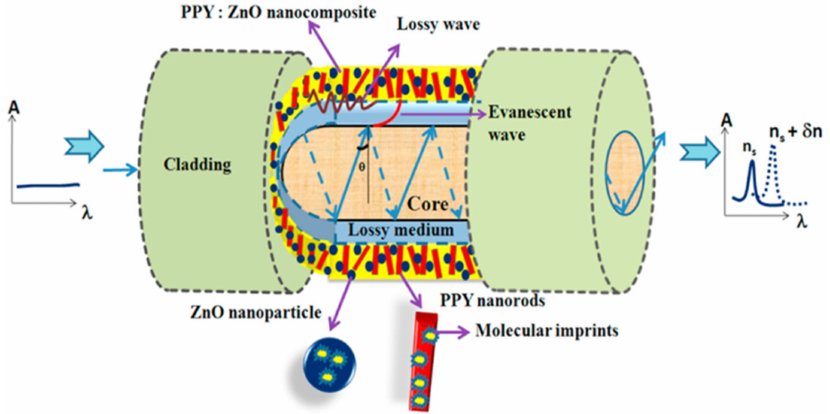
Figure 27. Schematic of LMR based fiber optic cortisol sensor probe using ZnO-PPY matrix as MIP host polymer. Reprinted with permission from Ref. [169]. Copyright 2017 Elsevier.